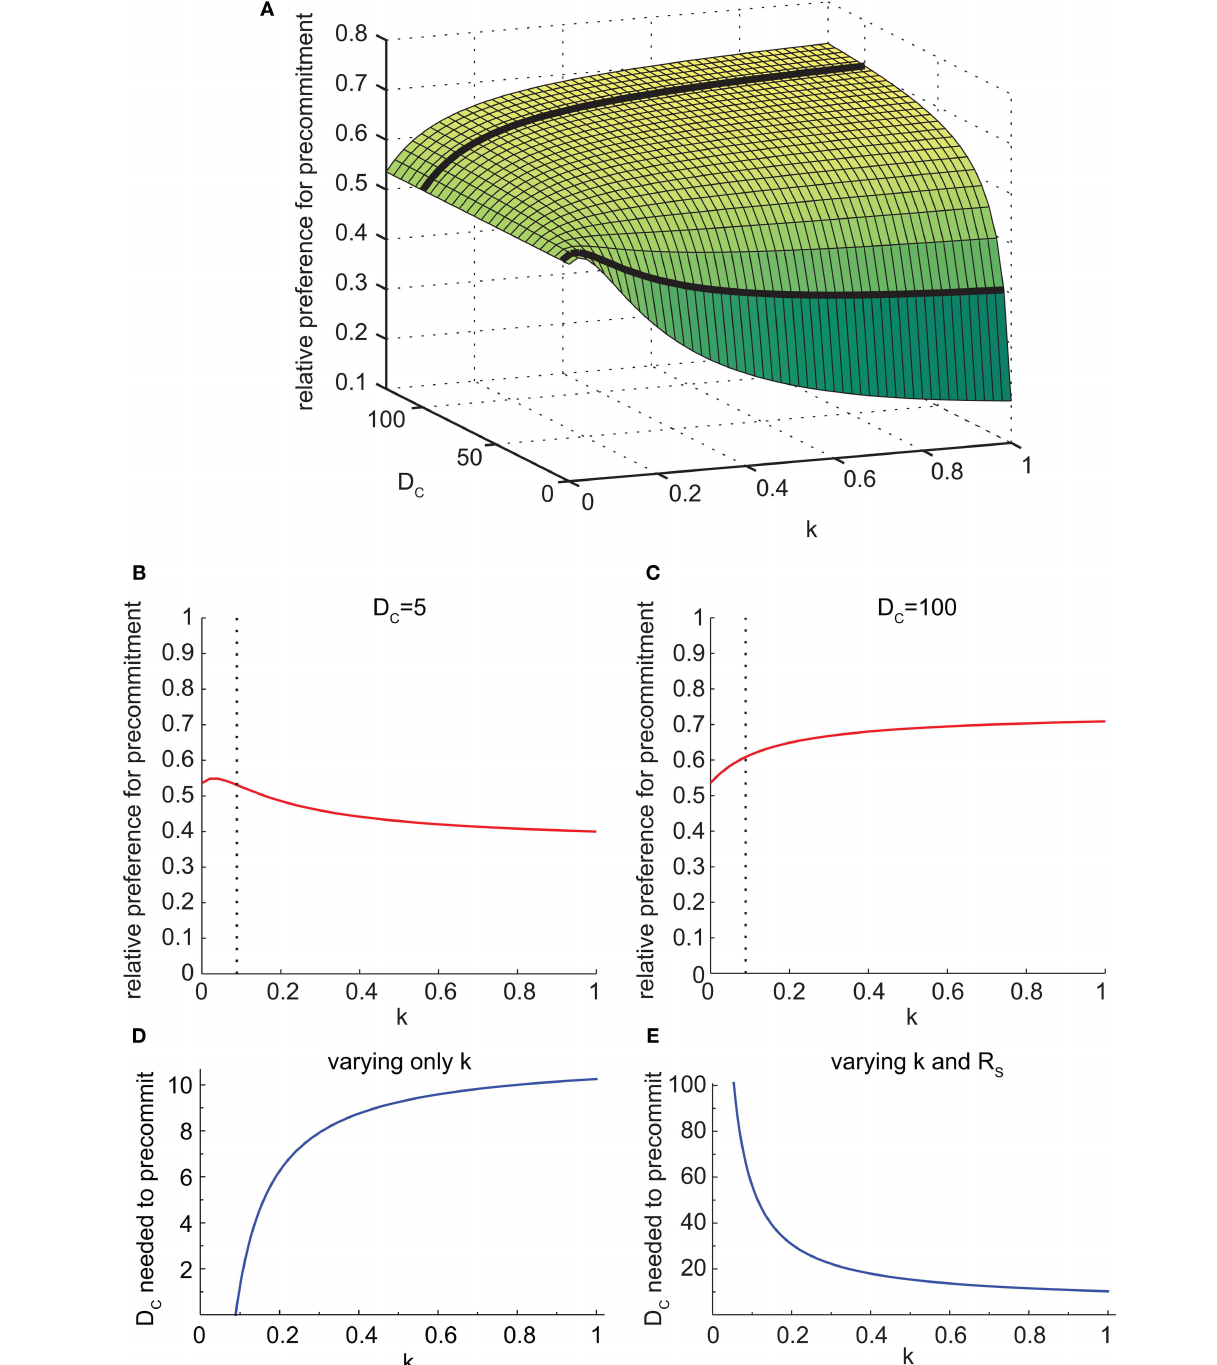
Figure 7 | The discounting rate has a complex interaction with precommitment behavior. (A) Precommitment preference plotted against k and D . The heavy black lines show the intersection of the planes D C D = 100 with this surface, representing the lines in (B) and (C) . (B) When D C was small ( D = 5), faster discounting yielded less precommitment. The C dashed line represents the value of k above which SS was preferred over LL. (C) When D was large ( D = 100), faster discounting yielded greater C C precommitment. The dashed line represents the value of k above which SS was preferred over LL. (D) As k increased, the amount of D